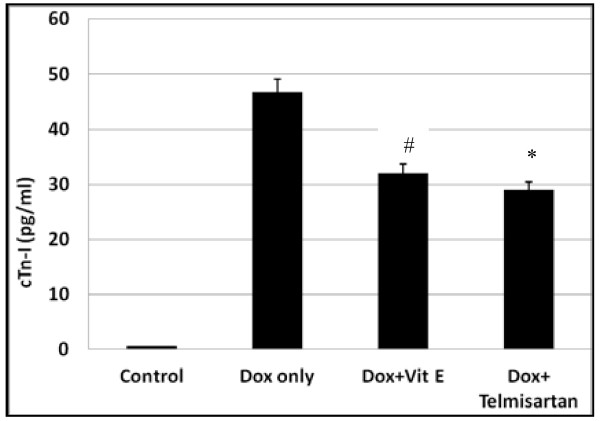
Cardiac troponin I is very sensitive and specific indicators of damage to the heart muscle (myocardium). in this figure the level of troponin I is significantly reduction in group of Dox + antioxidants agents; Data are expressed as mean ± SEM, #*P < 0.05; vs. Dox only only (n = 8 per group).